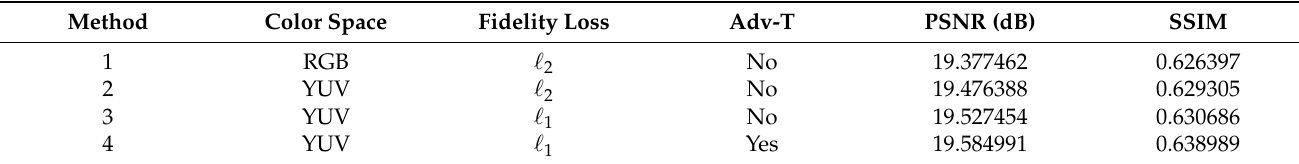
Table 4. Average PSNR and SSIM values of images reconstructed with various architectures—the Sentinel-2A test set.